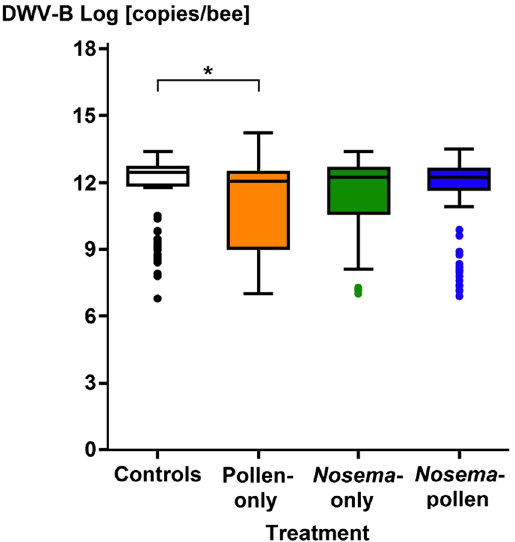
Figure 3. DWV-B infection loads of individual honey bee workers in the four treatment groups (Controls [white], Pollen-only [orange] Nosema -only [green], Nosema -pollen [blue]). Medians, ranges, confidence intervals and outliers ( = dots) are shown at a log scale. Workers contaminated with N. ceranae from the pollen- only treatment are not considered. Significant differences were found between the controls and the Pollen-only group ( * P <